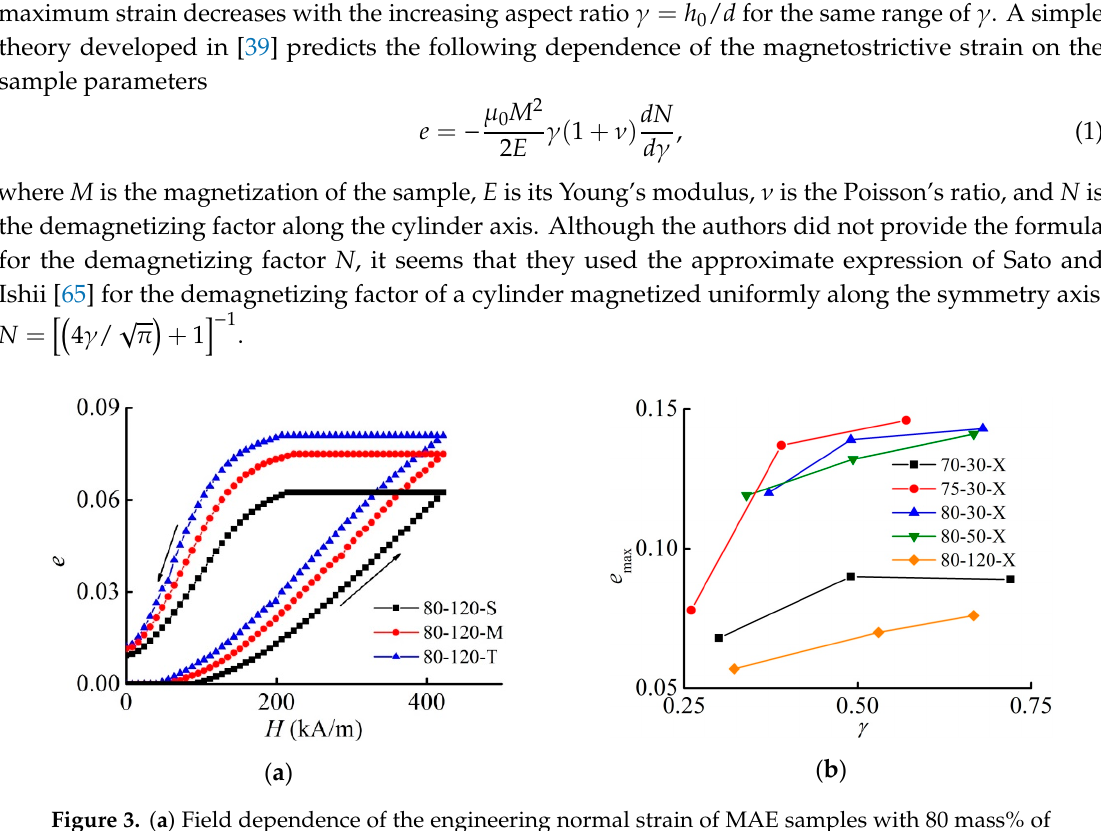
Figure 3. ( a ) Field dependence of the engineering normal strain of MAE samples with 80 mass% of iron and the quiescent shear modulus of 120 kPa for different aspect ratios. ( b ) Dependence of the maximum strain e max on the aspect ratio γ for different samples.